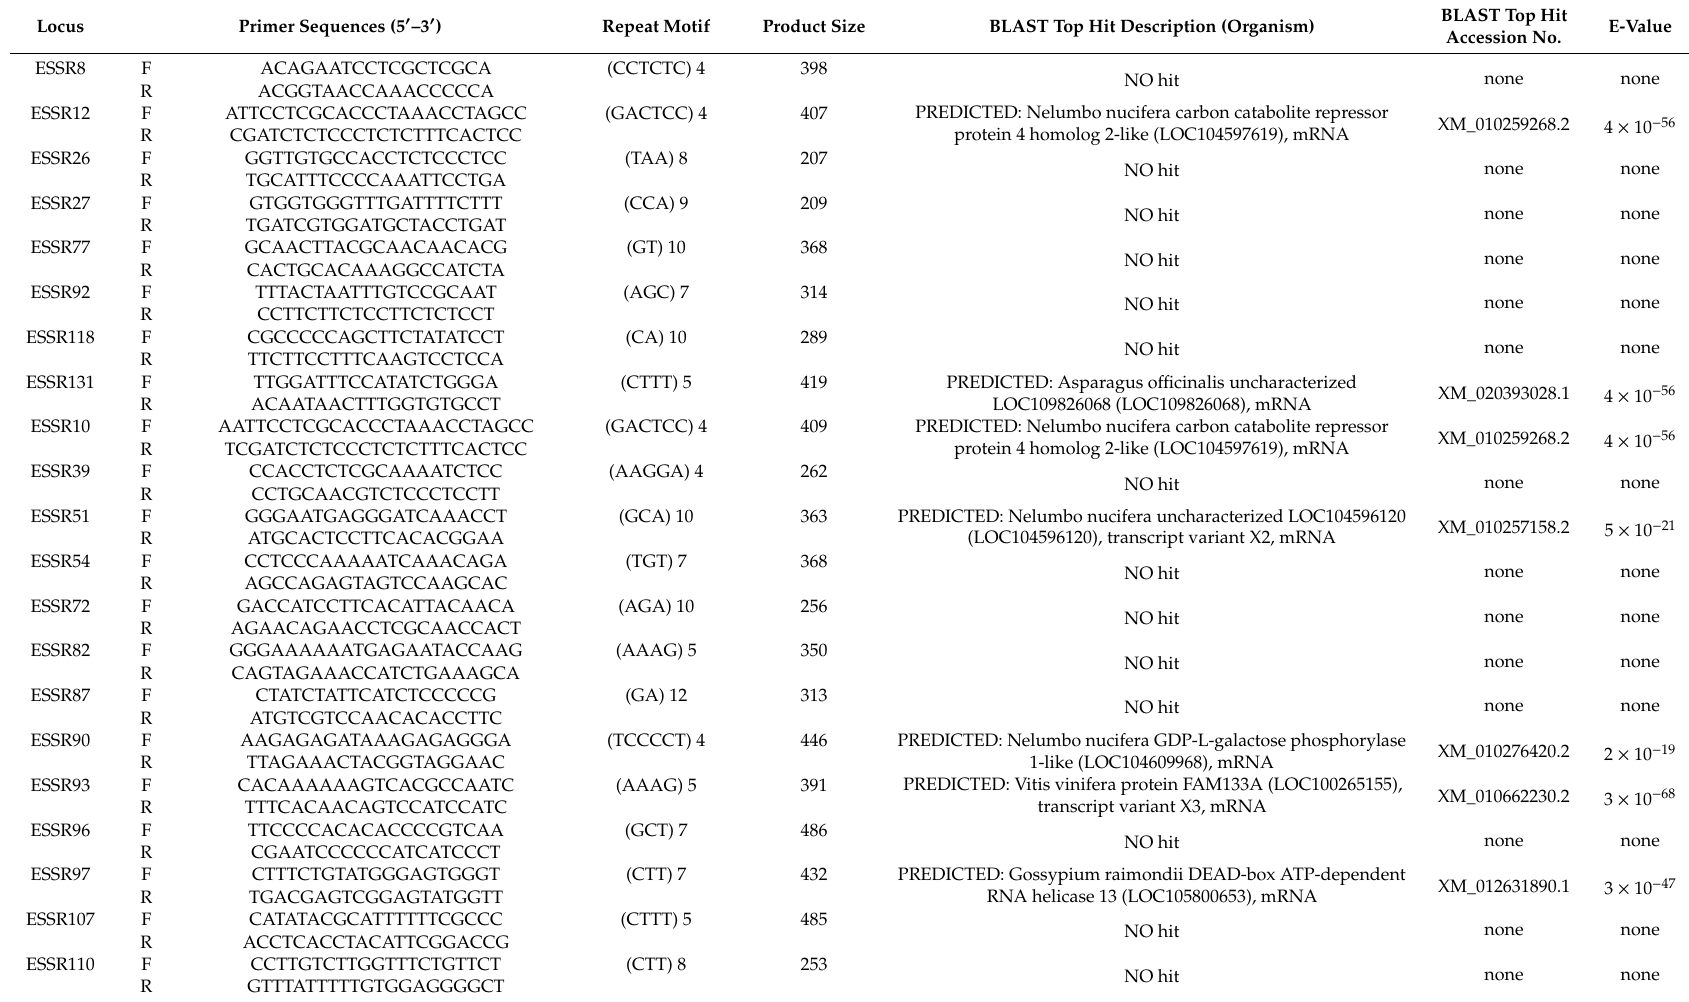
Table 1. Characteristics of 29 microsatellite primers developed for L. chinense and L.